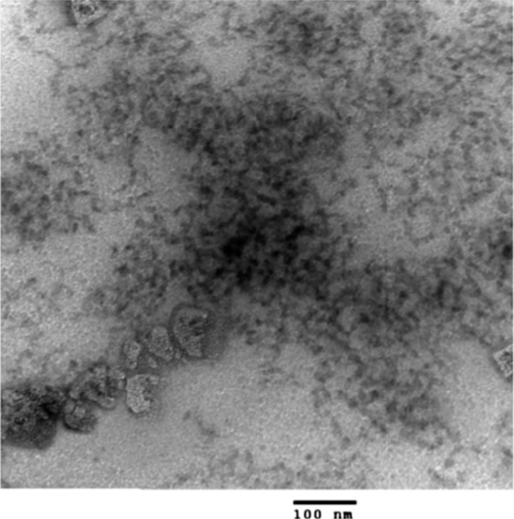
Figure 9. Cryo-TEM image of PDADMAC/TX100-SDS coacervate system. Reproduced with permis- sion from Soft Matter, 2013, 9 , 7320. Copyright 2013 Royal Society of Chemistry.